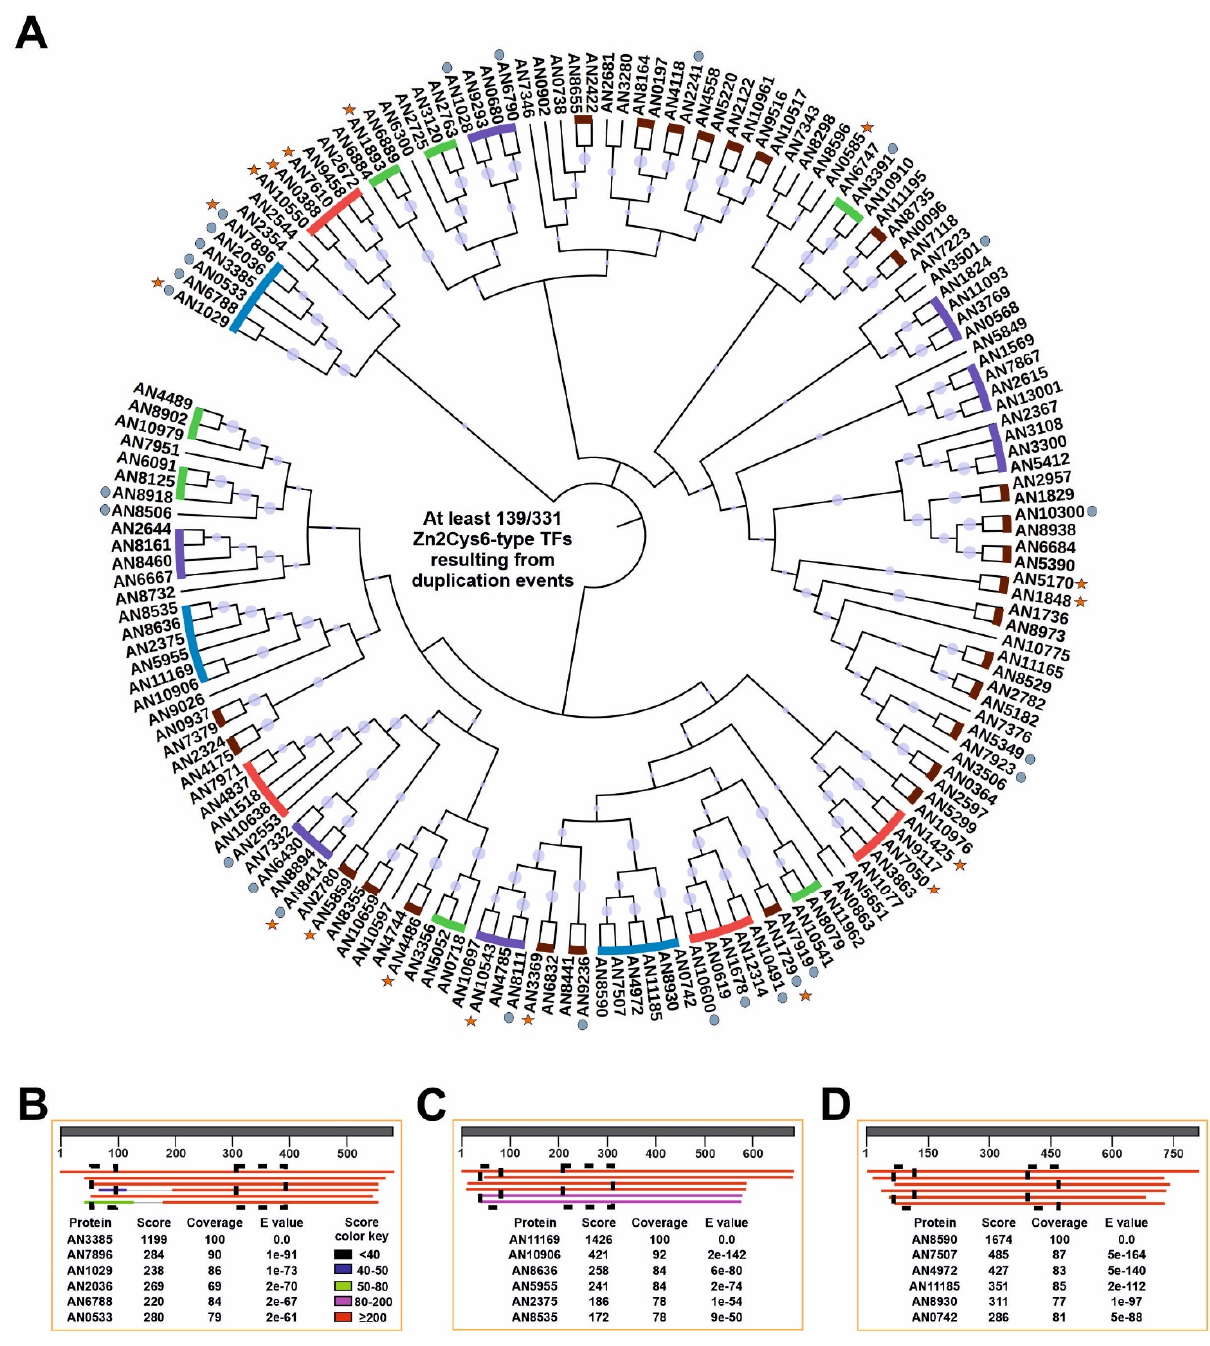
Figure 6. Duplication events within the zinc cluster family of TFs in A. nidulans . ( A ) Phylogenetic tree generated with Mega, version 7.0.26 (neighbor-joining method and 5,000 bootstrap replications), and edited using iTOL, showing the paralog clusters predicted by the CD-Hit suite. Predicted paralog clusters of 2, 3, 4, 5 and 6 members are highlighted with brown, green, purple, red and blue lines, respectively. Some Zn2Cys6-type TFs excluded from these paralog clusters (clusters of 1 member in the CD-Hit suite) were also included. Gray circles indicate those TFs predictably involved or shown to be involved in the control of secondary metabolism, while stars indicate TFs having a standard name. Bootstrap values are indicated by light purple circles. (B-D) BLAST alignments (NCBI website) for each of the three paralog clusters of six members identified by CD-Hit, using as queries AN3385 ( B ), AN11169 ( C ) and AN8590 ( D ), respectively. Score, expect and coverage values are included. The score color key is shown in panel B. The extension of Zn2Cys6 and fungal specific regulatory domains is shown in each panel with the black squares. The alignments of the sequences in each panel ( B – D ) can be seen in Figures S2–S4, respectively.